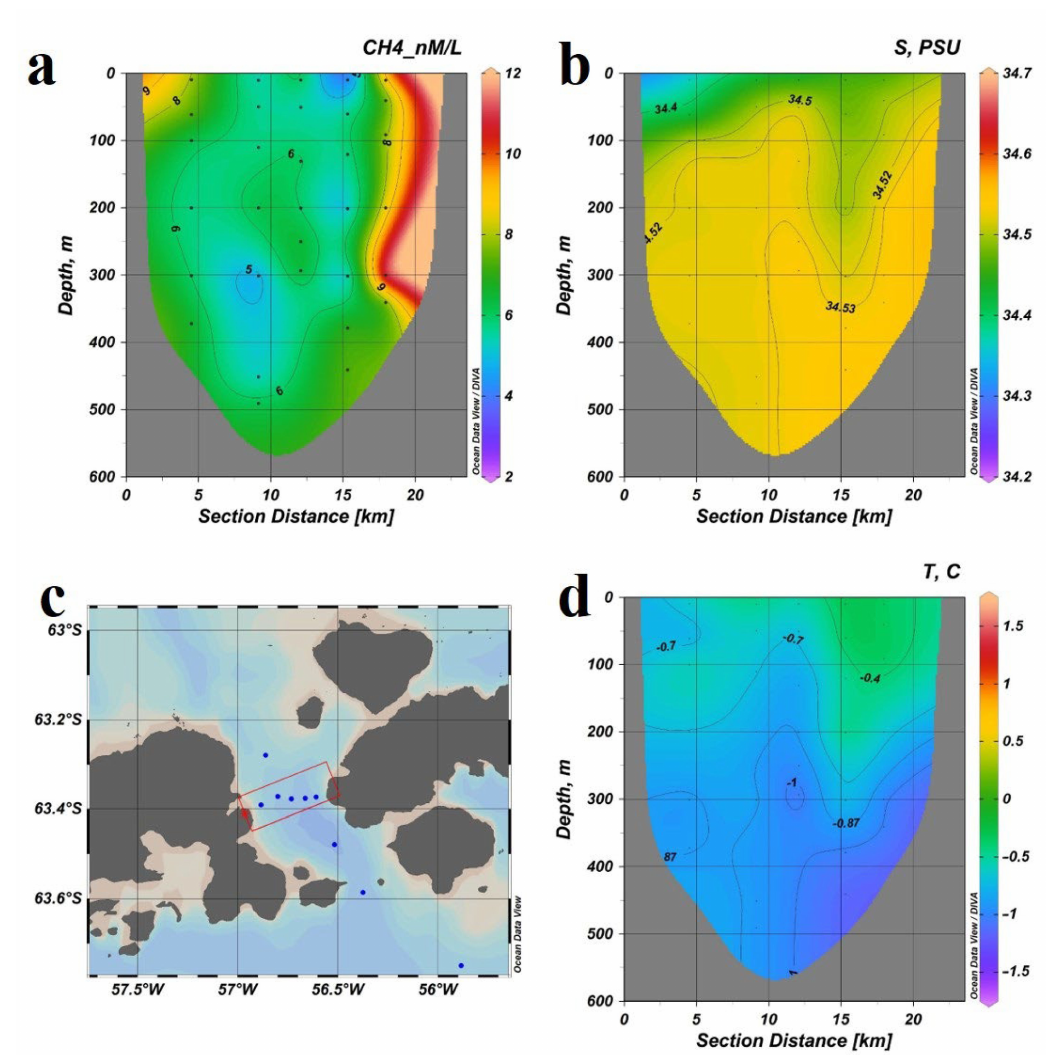
Figure 7. Distribution of methane concentration ( a ), temperature ( d ) and salinity ( b ) on a cross section ( c ) in the Antarctic